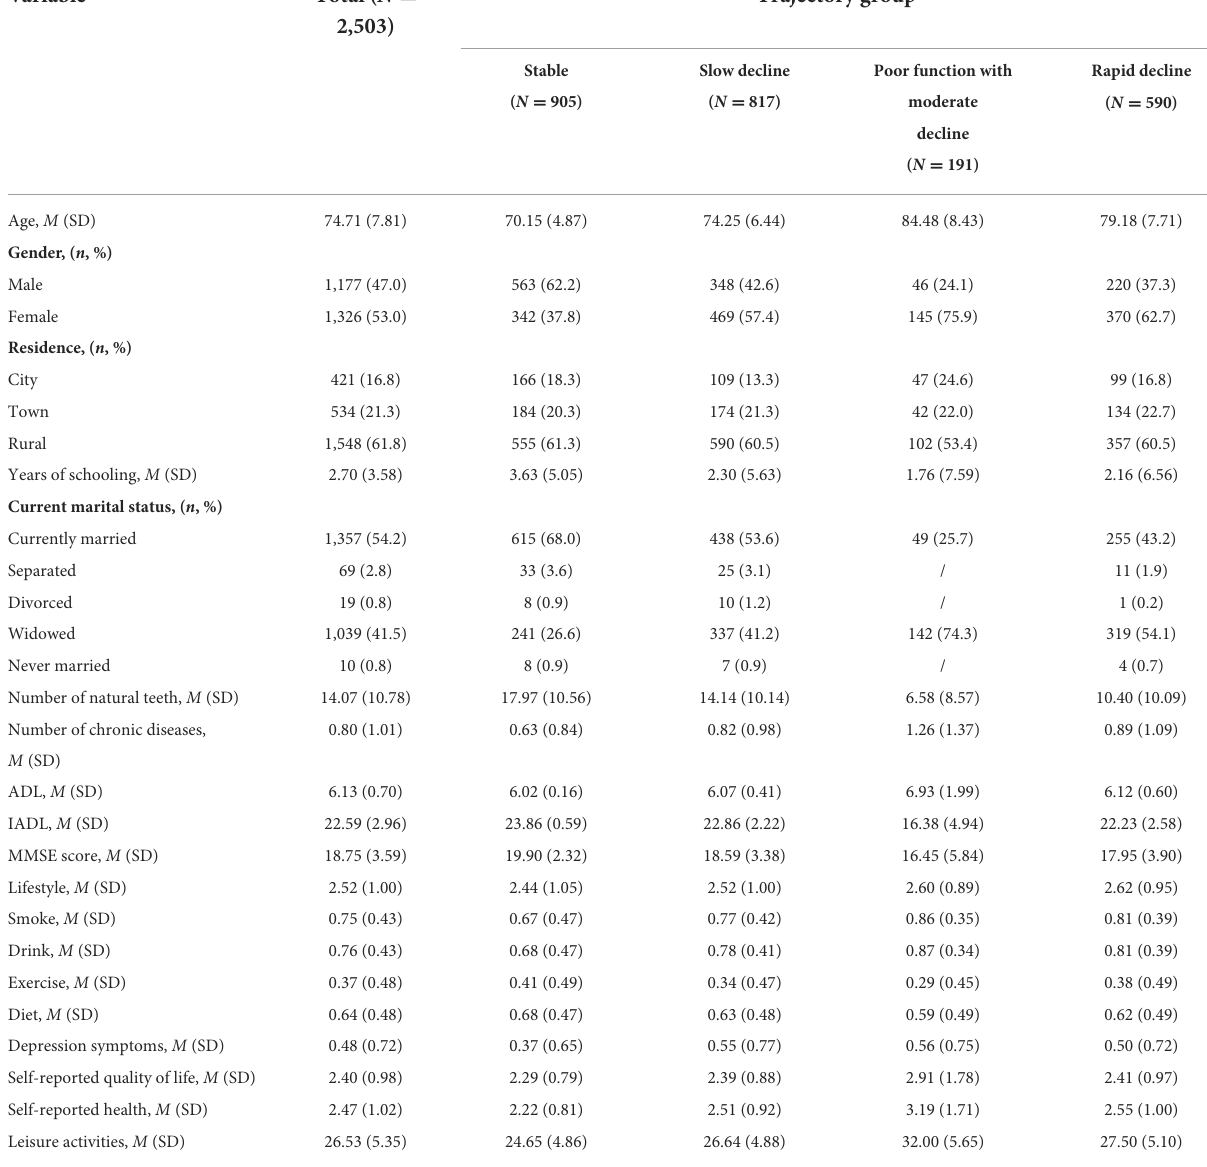
TABLE 2 Baseline characteristics of the total sample and the sample by the different trajectory groups.